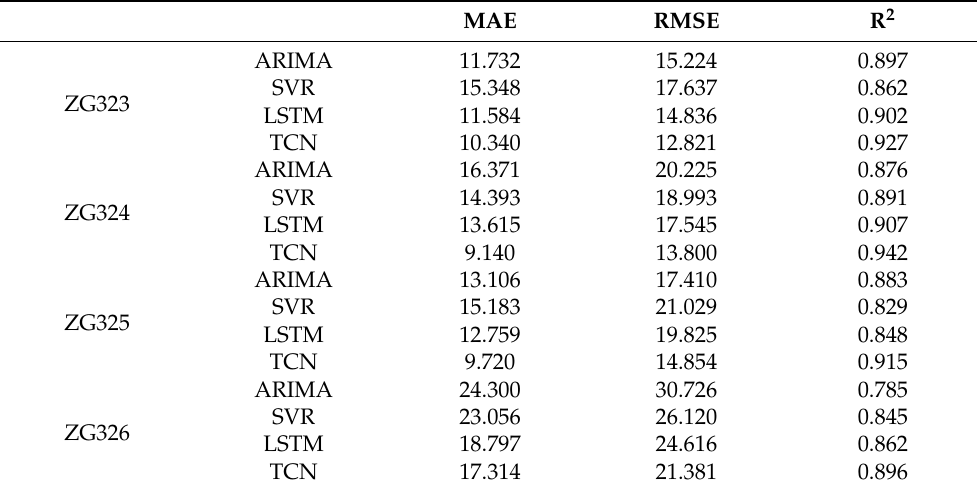
Table 7. Cumulative displacement of accuracy assessment with different predicted models in ZG323 to ZG326.